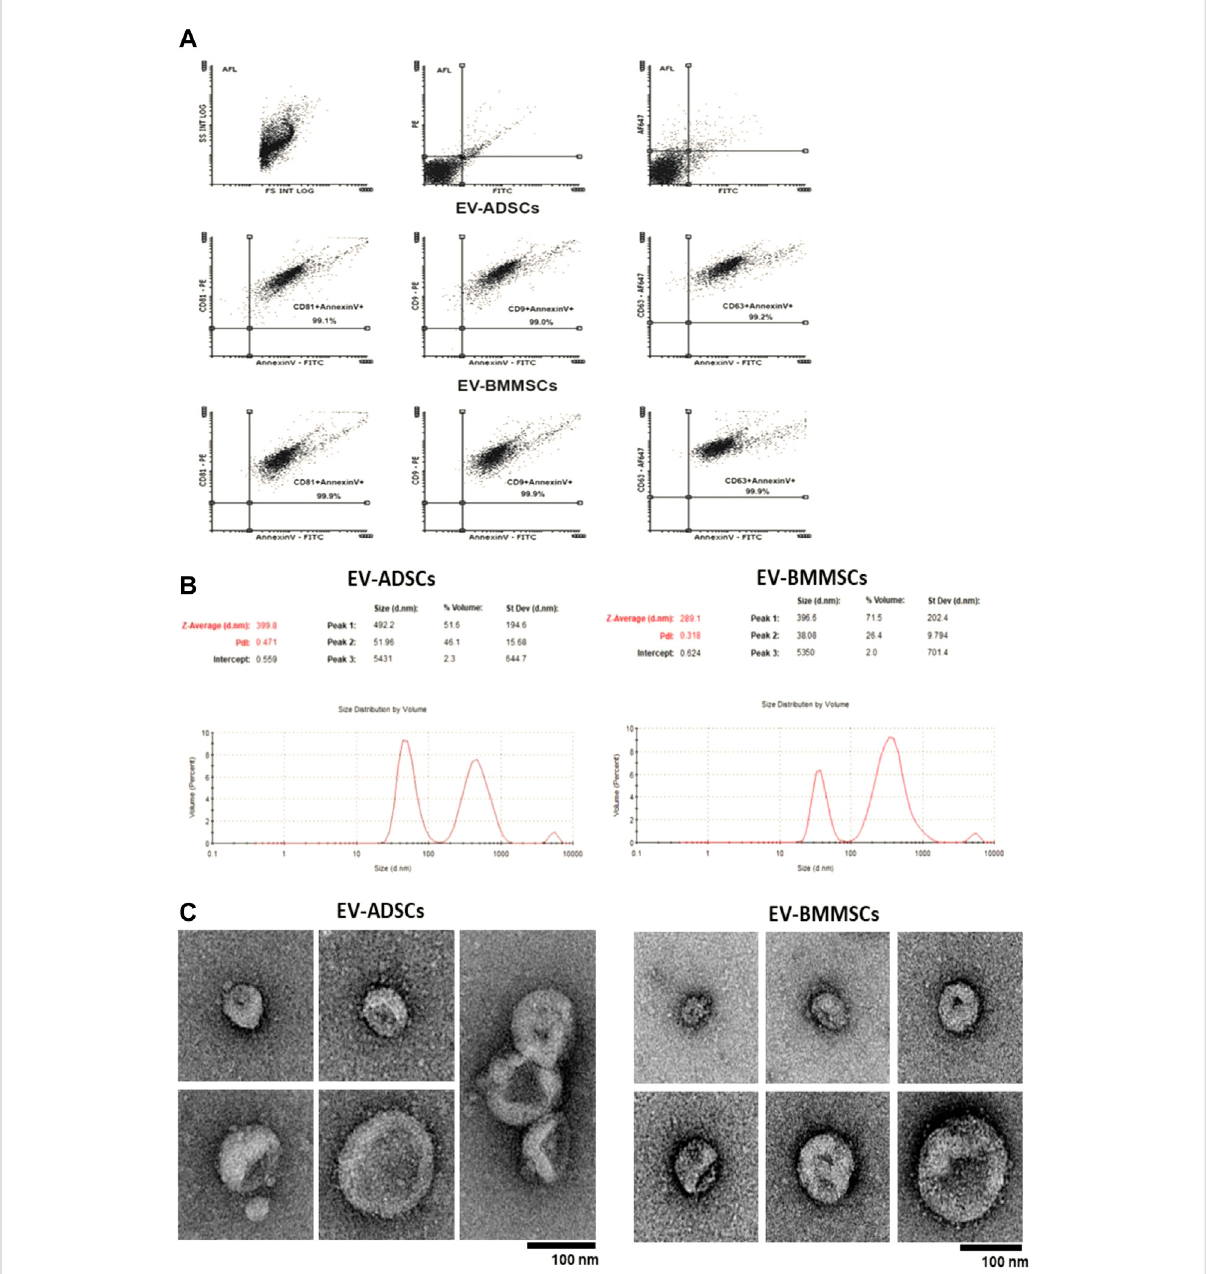
FIGURE 6 Detectionand characterizationEV-ADSCsand EV-BMMSCs: (A) Representativerecordingsobtained by fl owcytometry highlights thepresence of both exosomes (CD63 + , CD9 + , CD81 + ) and microvesicles (AnnexinV + ) in the fractions of EV-ADSCs and EV-BMMSCs; (B) Representative records for particle size distribution of EV-ADSCs and EV-BMMSCs emphasizes two different populations represented by the two peaks, the fi rst peak at the small size range (~50 – 100 nm) speci fi c to exosomes and the second at the high size range (~100 – 1000 nm) speci fi c to microvesicles (Y-axis represents the number of EVs and the X-axis represents the size of EVs); (C) Electron microscopy negative staining images of EV-ADSCs and